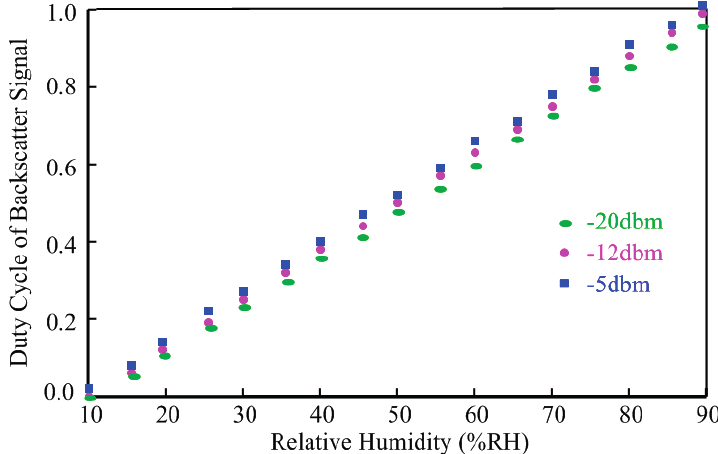
Figure 10. Duty cycle of backscatter signal versus relative